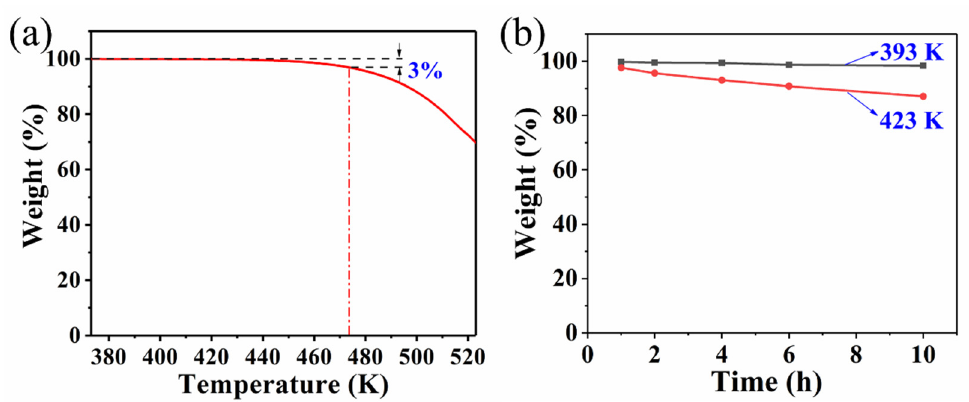
Figure 7. ( a ) Thermogravimetric (TG) curve of CQDs / PC phosphor. ( b ) Residual weight of CQDs / PC phosphor after keeping at 393 and 423 K with different times in air.